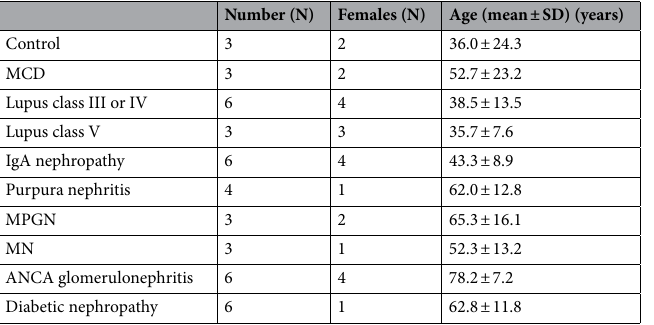
Table 1. The characteristics of the subjects included in this study. MCD: Minimal change disease. Lupus: Systemic lupus nephritis. MPGN: Membranoproliferative glomerulonephritis. MN: Membranous